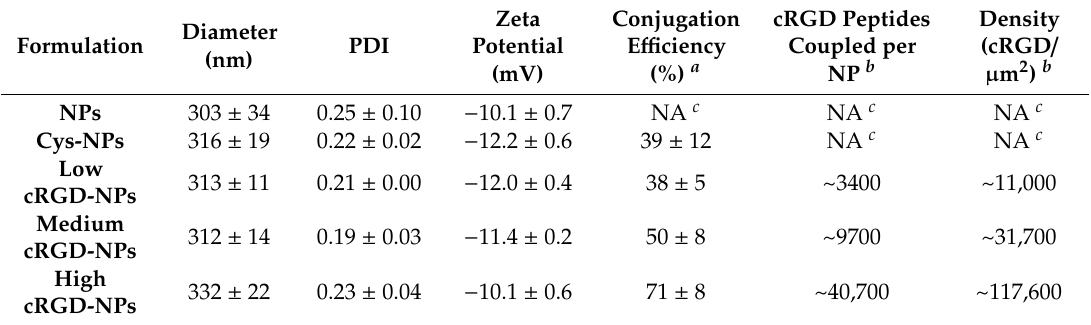
Table 1. Z-average diameter, polydispersity index, zeta potential and conjugation e ffi ciency